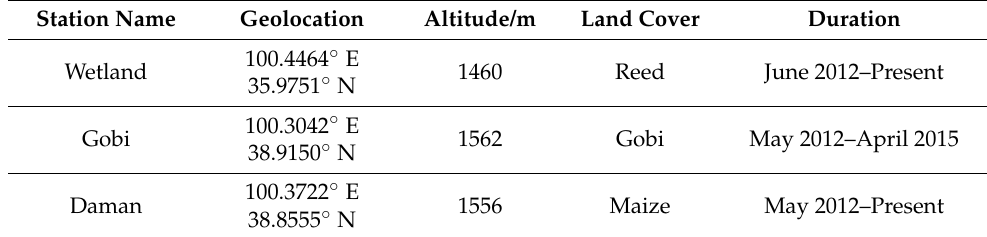
Table 1. Verifying station